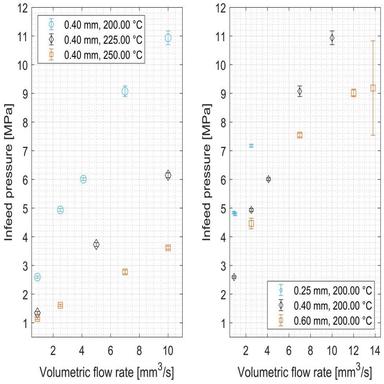
Infeed pressure versus volumetric flow rate for the 0.40 mm nozzle orifice diameter at different hot end temperature setpoints (left) and infeed pressure versus volumetric flow rate for different nozzle orifice diameters at a hot end temperature setpoint of 200 ◦C (right). The error bars represent one standard deviation of the infeed pressure.